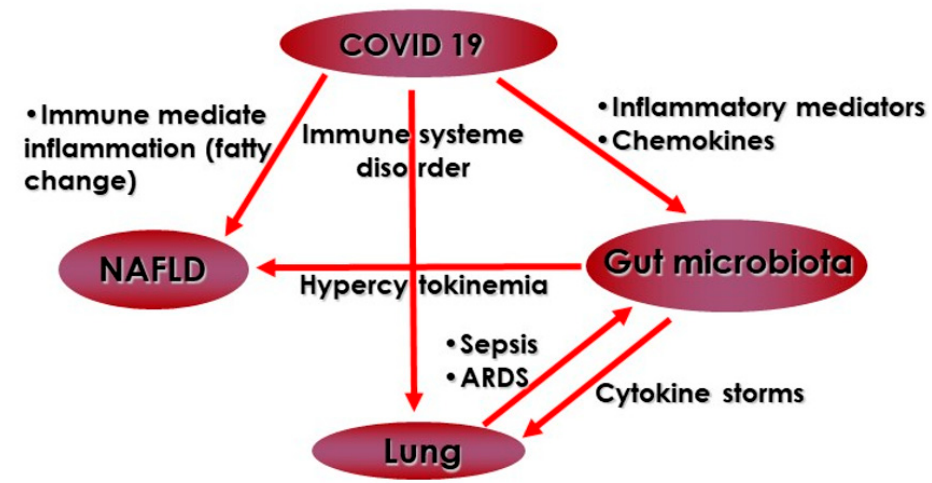
Figure 1. Possible interactions between gut microbiota, NAFLD and COVID-19.